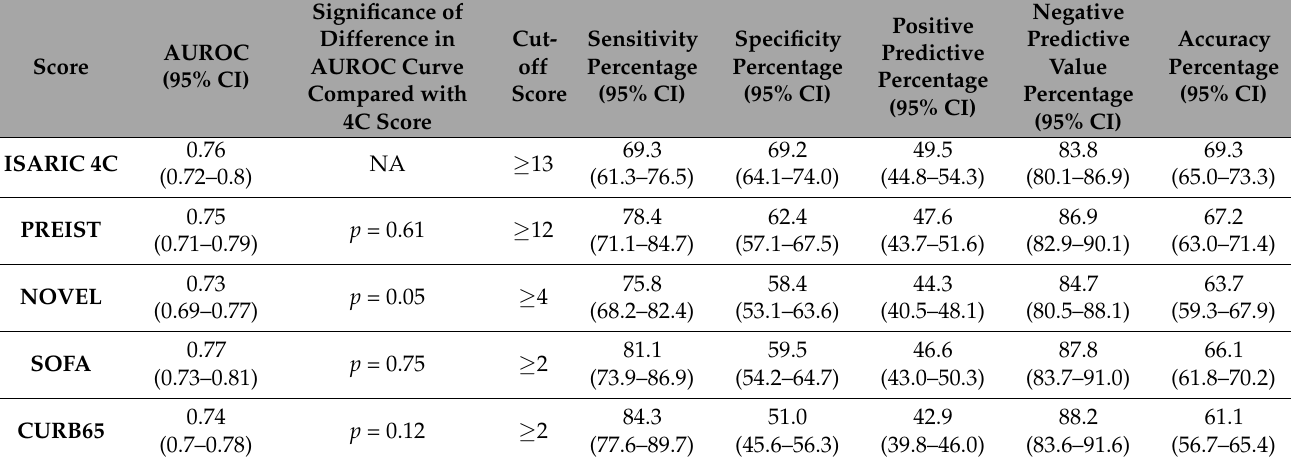
Figure 3. Receiver operator characteristic (ROC) curves for the ISARIC 4C, CURB65, REDS, NEWS2 and qSOFA scores. Table 2. The AUROC curves, cut-off points and test characteristics of the scores.